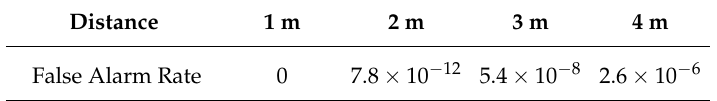
Table 2. Performance analysis in a light clutter environment when P Fa = 10 − 4 , P Md = 10 − 3 , α = 0.3.